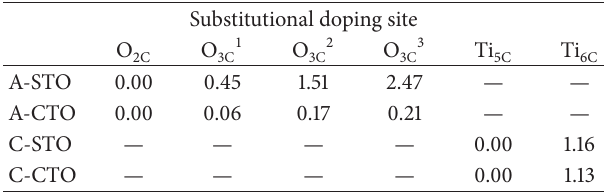
anatase (101) surface. A-STO and A- 2 O S and Ti O C; C-STO 24 47 24 47 SO and Ti CO , 23 48 23 48